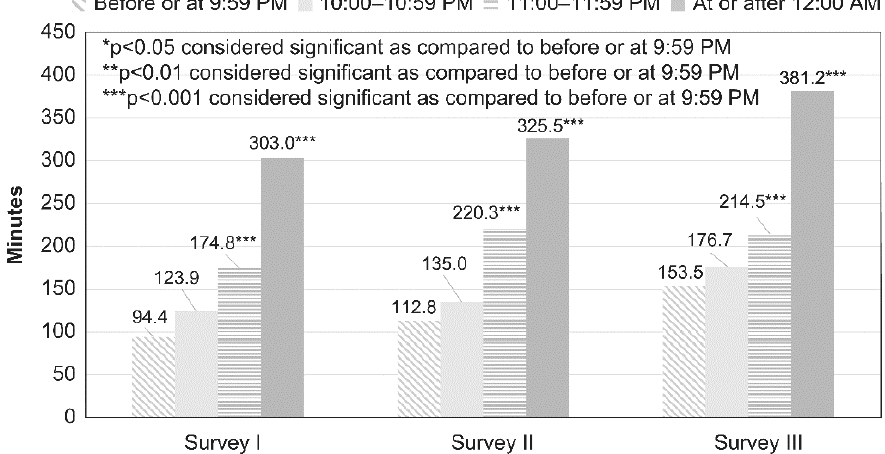
Figure 2. Average daily Internet minutes on holidays by bedtime on holidays in each survey. A comparison of the duration of internet use (in minutes) on holidays among groups as per bedtime was performed using ANOVA. A post hoc analysis between the group with bedtime before or at 9:59 PM and groups with bedtime at or after 10:00 PM (10:00–10:59 PM, 11:00–11:59 PM and at or after 12:00 PM) was performed using Dunnett’s test. A p value of 0.05 was considered statistically significant. All statistical analyses were performed using SPSS